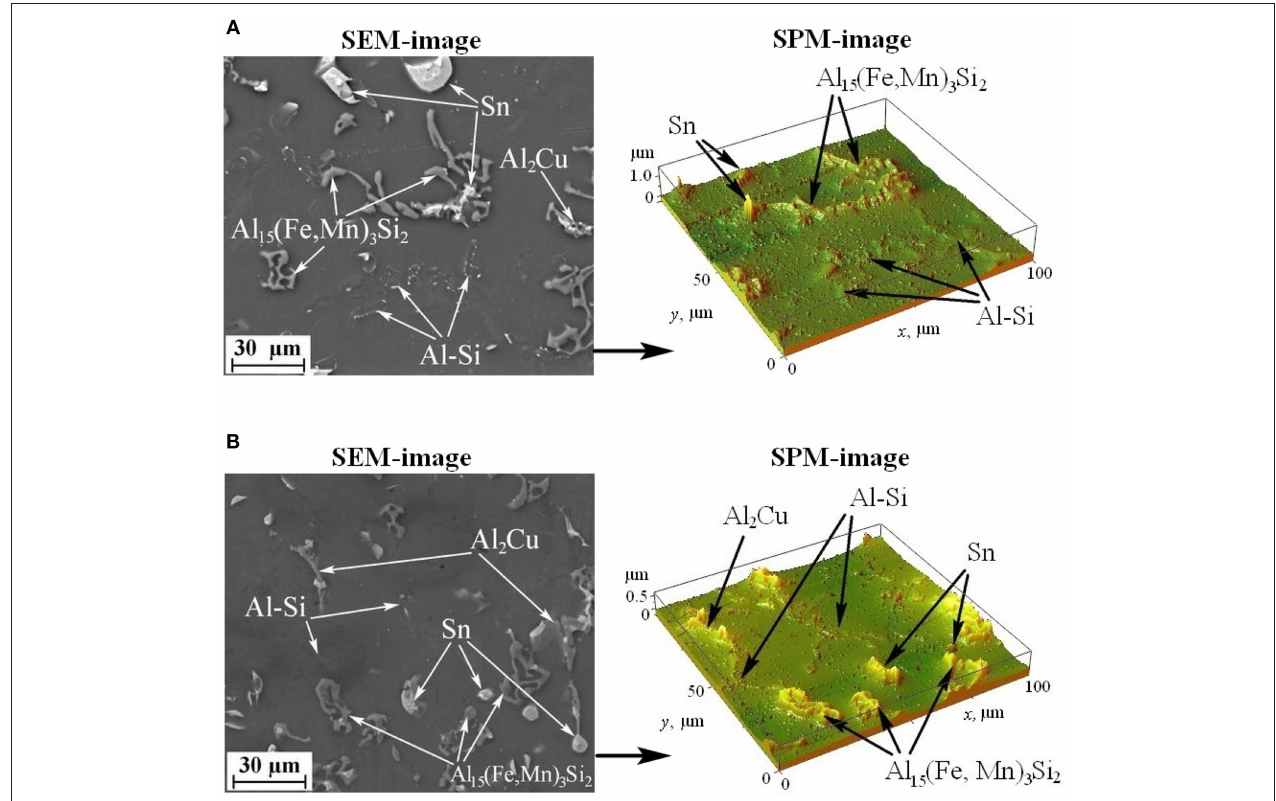
FIGURE 1 | SEM and SPM (3D) images of the polished surface of the experimental alloy No. 1: (A) in the cast state, (B) in heat-treated state.